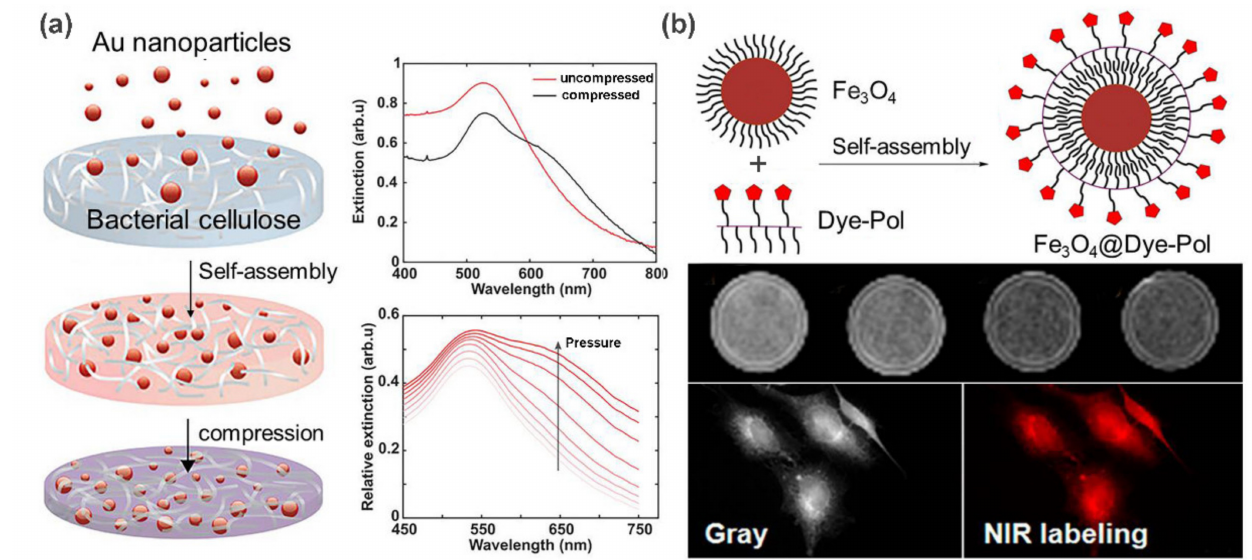
Figure 3. ( a ) Fabrication of mechanoplasmonic-responsive BC-AuNPs nanocomposite membranes. UV-vis spectra show the pressure-induced redshift in peak position. ( b ) Schematic illustration of the hybrid nanoparticle formation directed by hydrophobic interactions. MR imaging and NIR imaging results with Fe 3 O 4 @Dye-Pol. Adapted with permission from Refs.